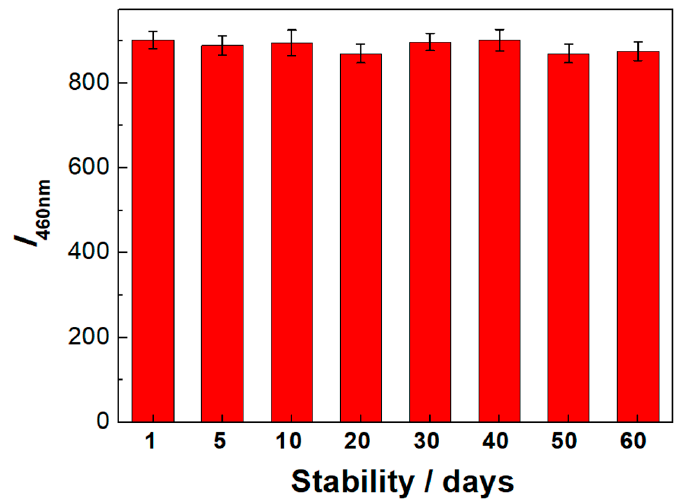
Figure 3. Fluorescent intensity at 460 nm ( J 460nm ) of dopamine-functionalized fluorescent C-dots within two months. λ ex : 285 nm. 3.2. The Feasibility of ClO − Detection Using Dopamine-Functionalized Fluorescent C-Dots